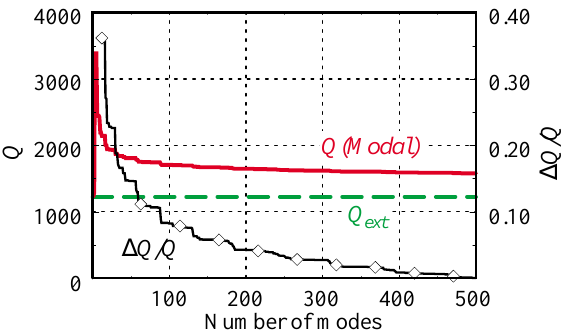
FIG. 7. (Color) Convergence curve of the calculation of the Q value of mode No. 10 ( f (cid:1) 3.3344 GHz) using the modal ap- proach. Related to the “final” value Q (cid:1) 1578 (including 500 cavity modes), we need about 90 modes to obtain a relative ac- curacy of 10%. The (easy accessible) value Q ext from (11) is a lower bound for Q . 2 These cavity modes, which only couple due to the nonsym- metric computational grid, deteriorate the time domain analysis as mentioned above. In the frequency domain they do not sig- nificantly contribute to the Q